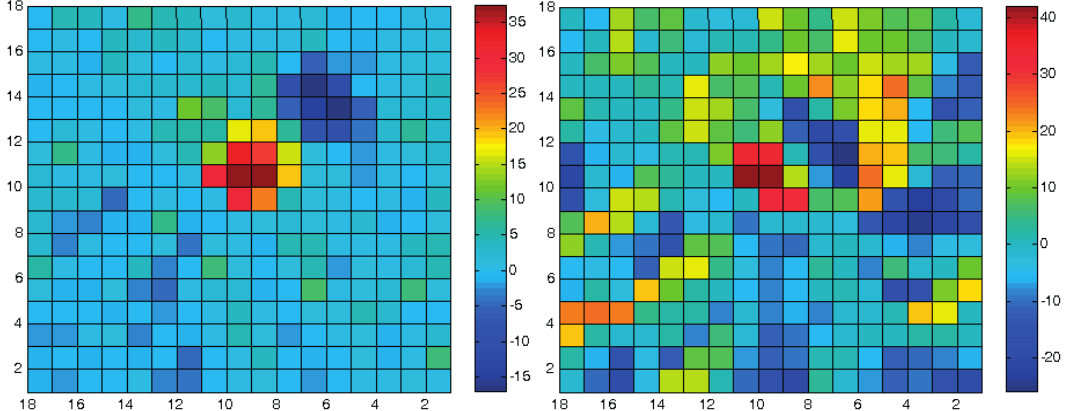
Figure 15. d z displacement values for matched frames—proposed hierarchical mechanism ( left ), and straightforward coordinate-based superposition ( right ). Values are in